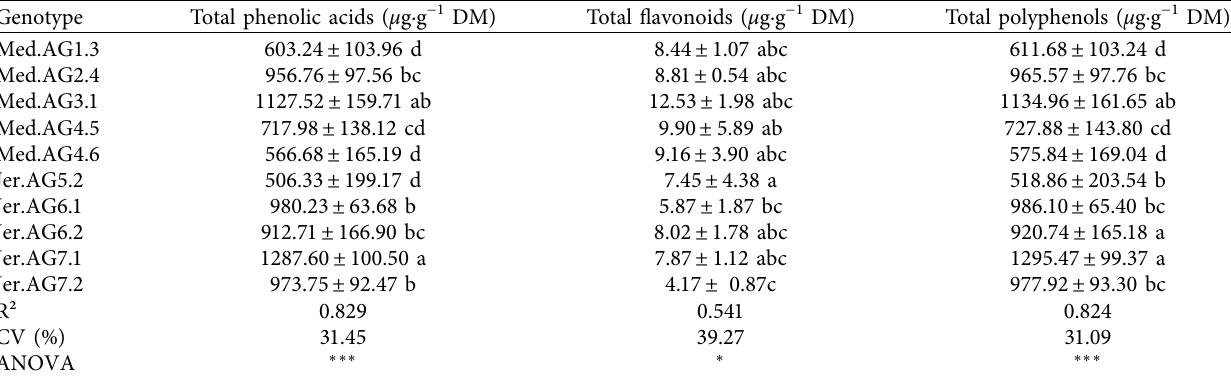
Table 3: Total phenolic composition contents of the methanolic extracts obtained from the grain millet genotypes.